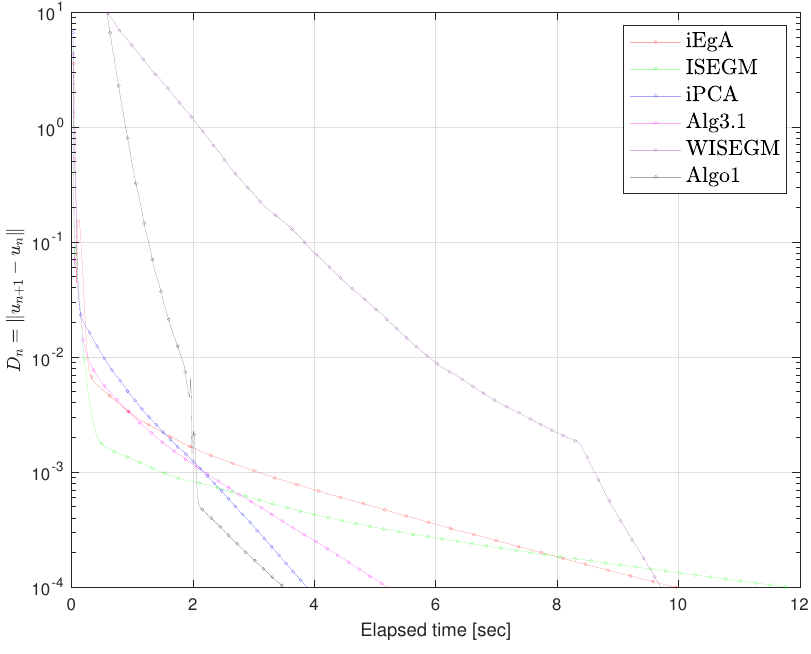
Figure 4. Example 1 in R 50 : Elapsed time 9.95, 11.79, 3.87, 5.19, 9.70, 3.41